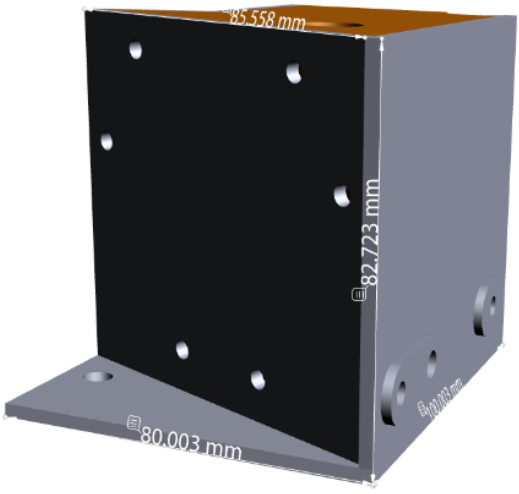
Figure 3. Nominal star tracker camera bracket.